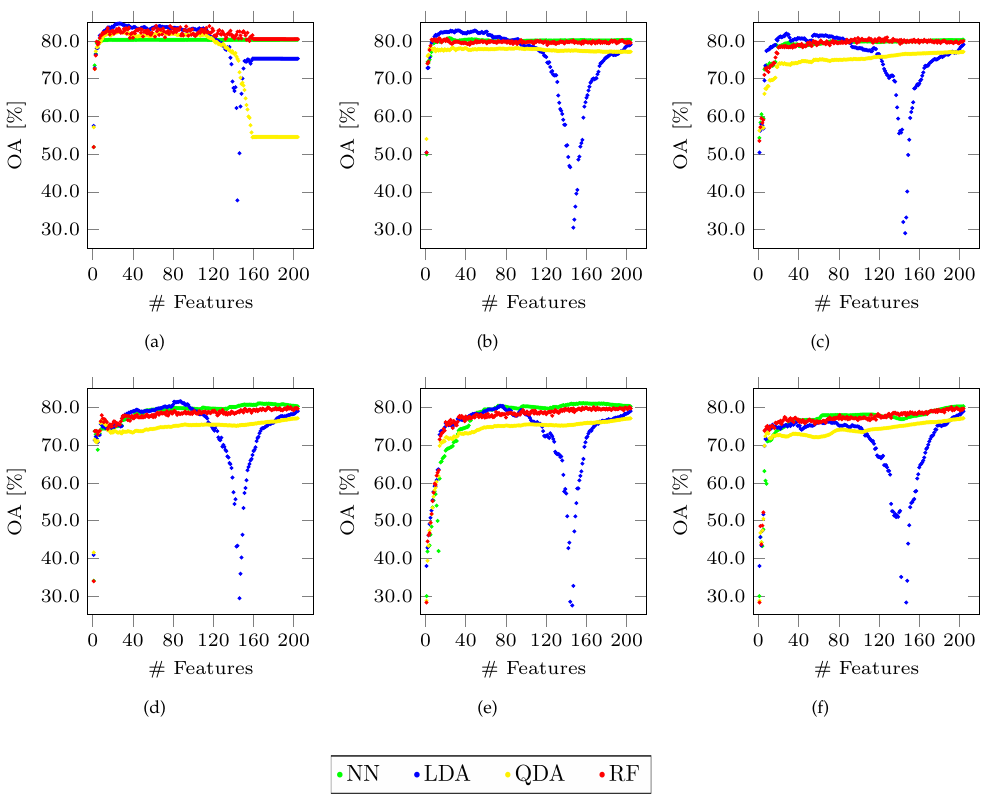
Figure 8. Classification results derived for the Salinas dataset (16 classes) via sequential forward selection when using ( a ) the PCA; ( b ) the RF-MDPA; ( c ) the GRM; ( d ) the MUI; ( e ) the TUI and ( f ) the BOFR. Table 3. Classification results derived with the Random Forest (RF) classifier for the Pavia University dataset (9 classes).